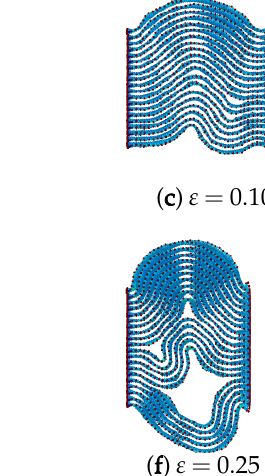
(e) n = 60 Figure 8. Deformation of zigzag graphite under compression( ε = 0.20).